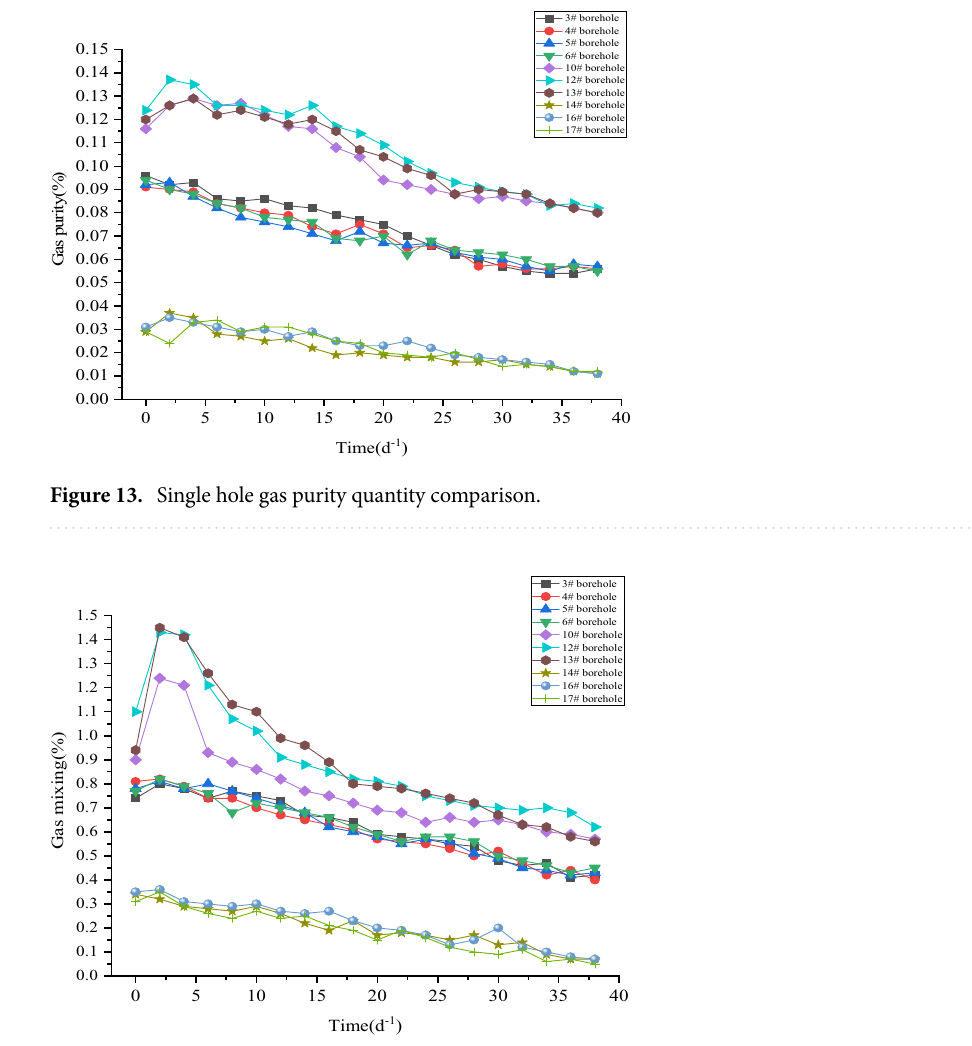
Figure 14. Single hole gas mixing quantity